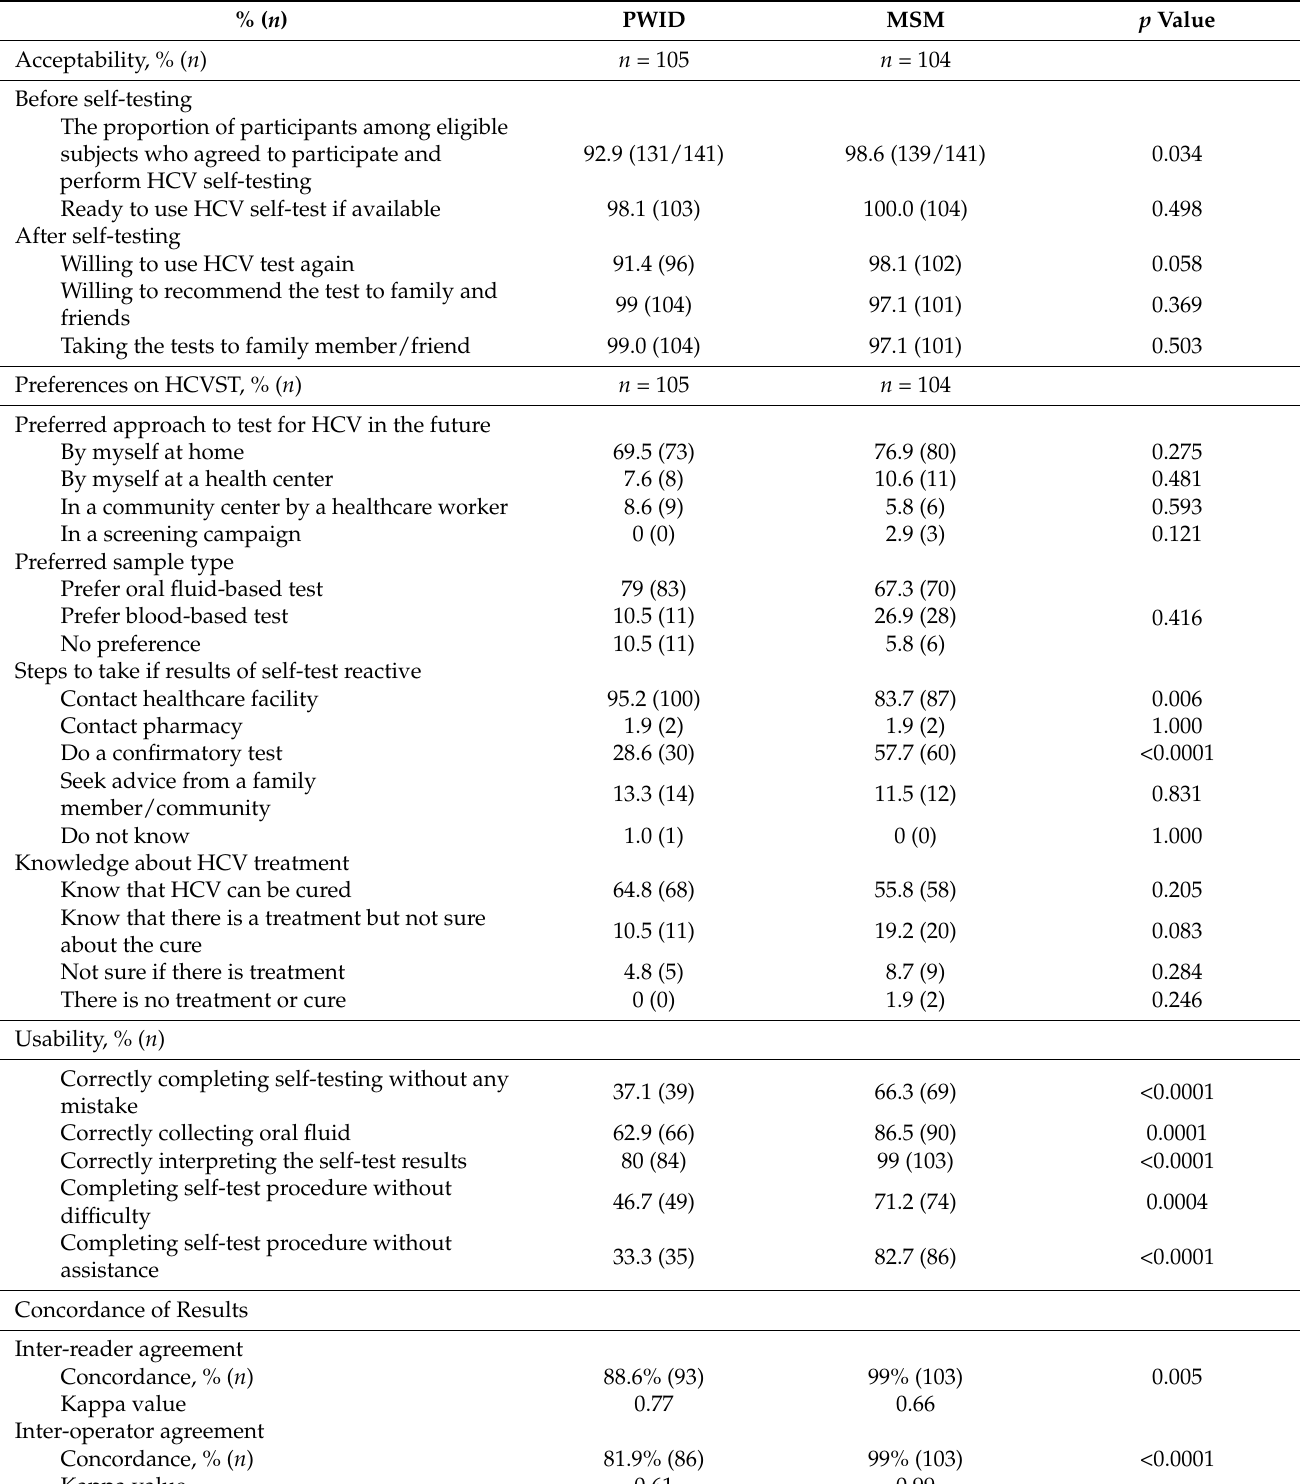
Table 7. Summary of acceptability, preference, usability and concordance results of HCV self-testing